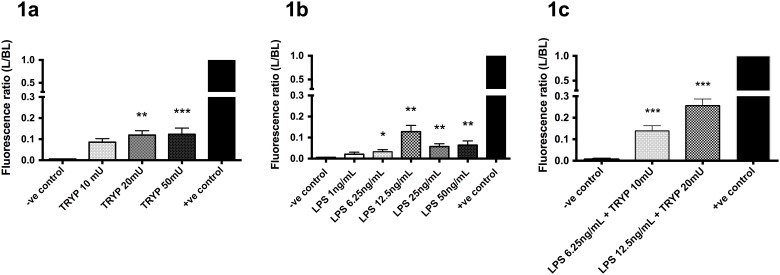
Permeation of FD4 (mean ± SEM) after exposure to different concentrations of TRYP (1a); LPS (1b) and combination of TRYP and LPS (1c).*P < 0.05; **P < 0.01; ***P < 0.001 compared to negative control (medium only). Analyses were based on at least 5 spheroids per experiment. Experiments were carried out three independent times.